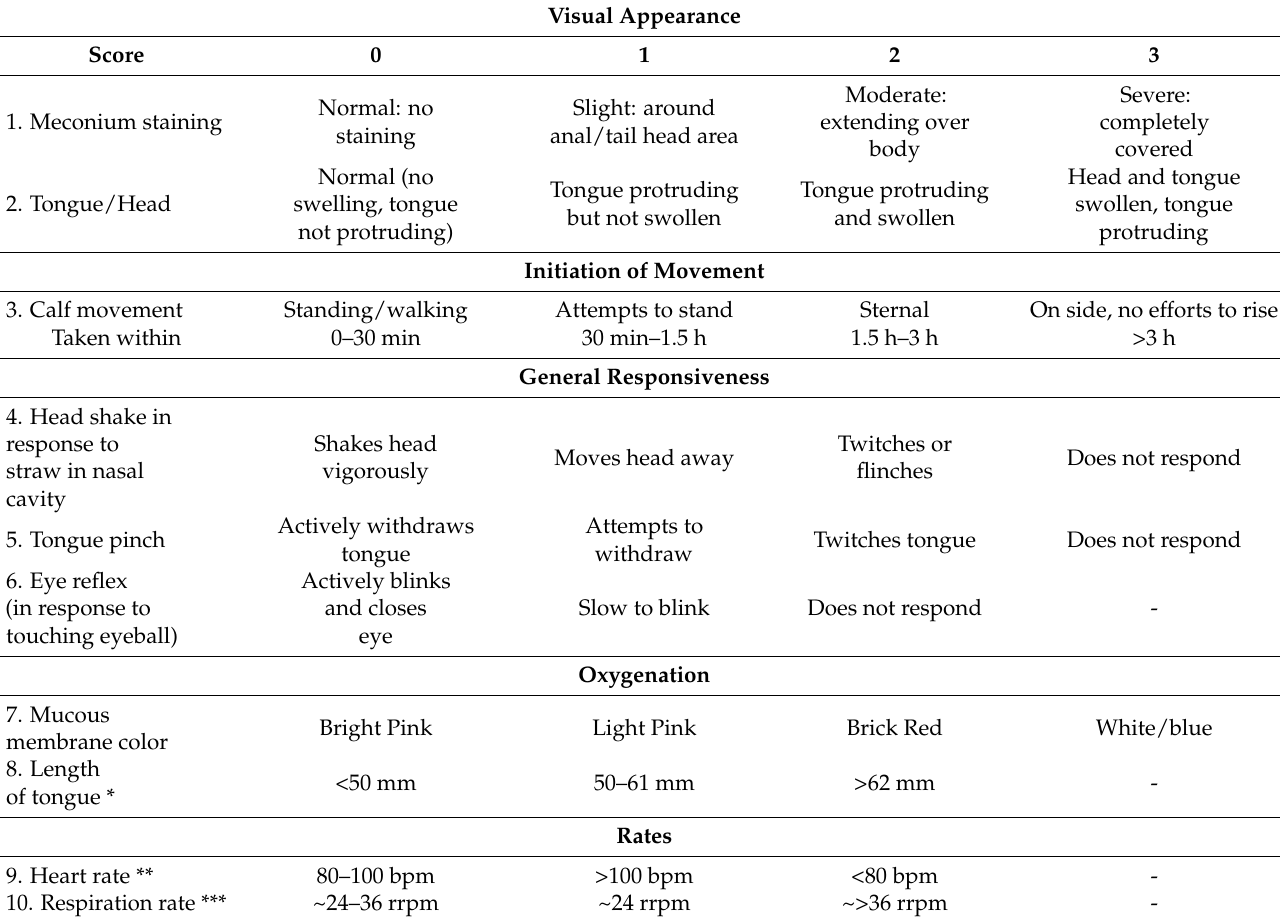
Table 7. Calf VIGOR score sheet recommended by Murray